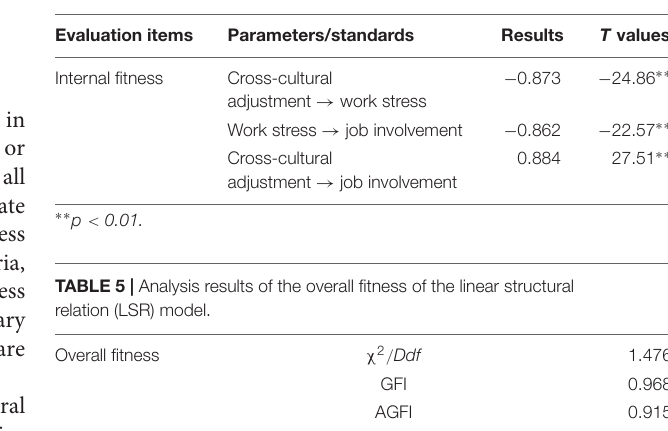
TABLE 4 | Analysis results of overall linear structural relation (LSR) model.